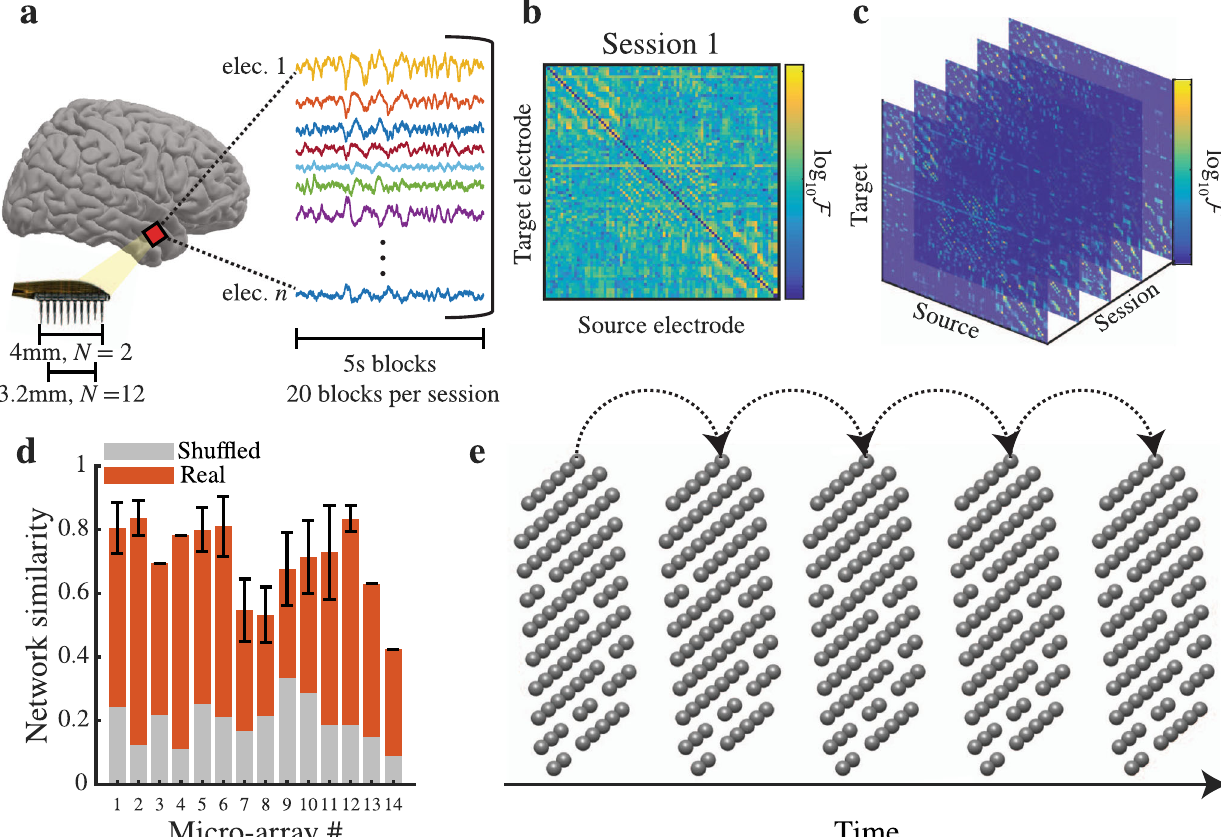
Fig. 1| Directedfunctionalconnectivity in localcorticalnetworks.a Schematic of recordingsand individual blocks. From each MEAwe extract20 data blocks, 5s each, for functional connectivity analysis. b Weighted and directed adjacency matrix for a singlesession. For each session we constructa weighted and directed adjacency matrix by computing the pair-wise conditional Granger causality, F , between every pair of electrodes. For ease of visualization the colormap shows log 10 F . c For each individual MEA we threshold the adjacency matrix from each session and set all values that were not signi fi cantly different from zero equal to zero. The end result is a series of adjacency matrices, or layers, where each layer